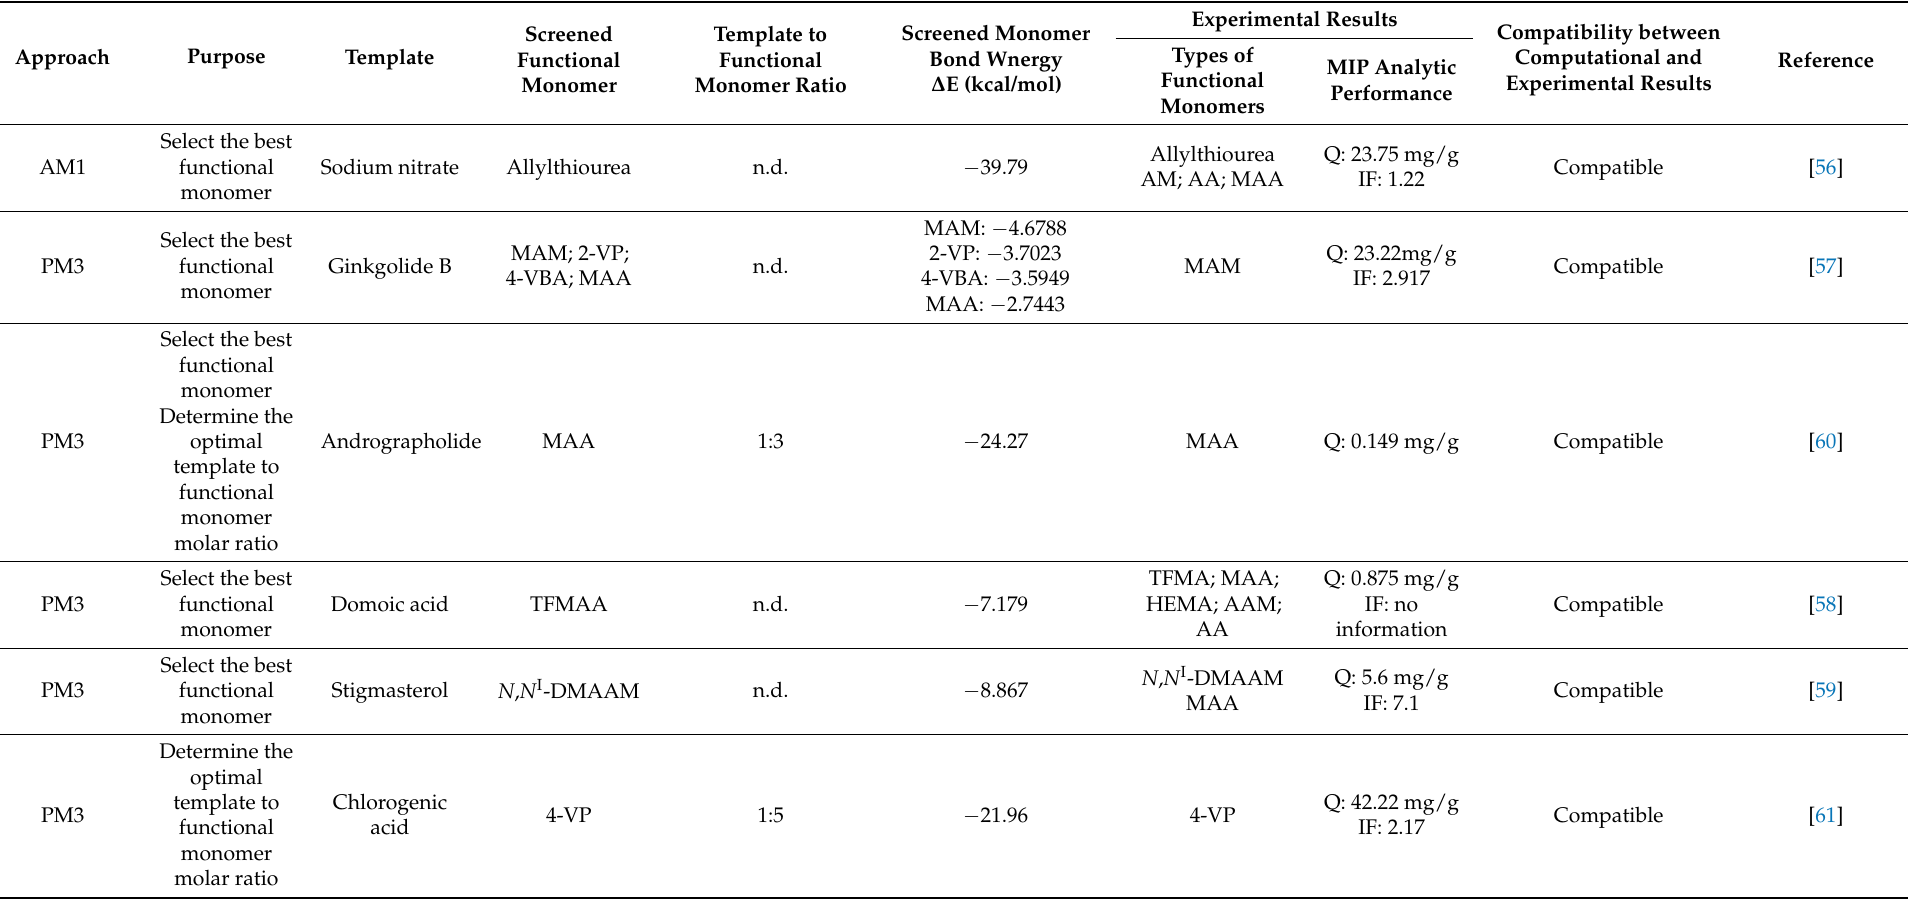
Table 4. Molecularly imprinted polymer (MIP) design using semiempirical